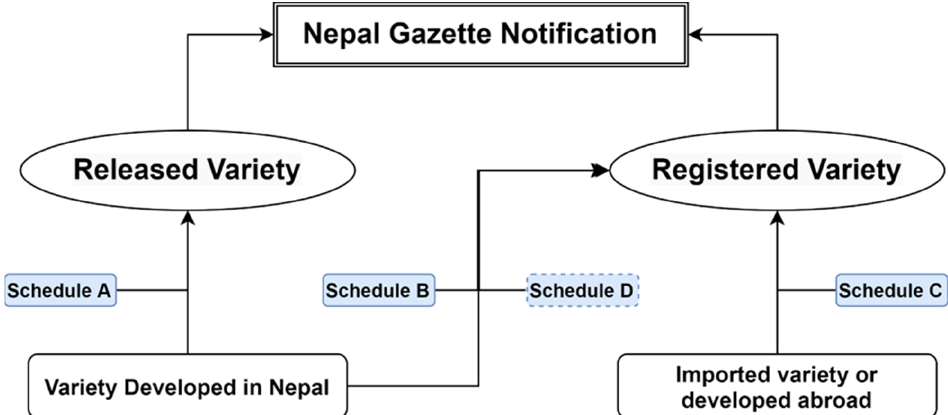
Figure 4. Notification process of new varieties in Nepal gazette (Source: adapted from [33]).